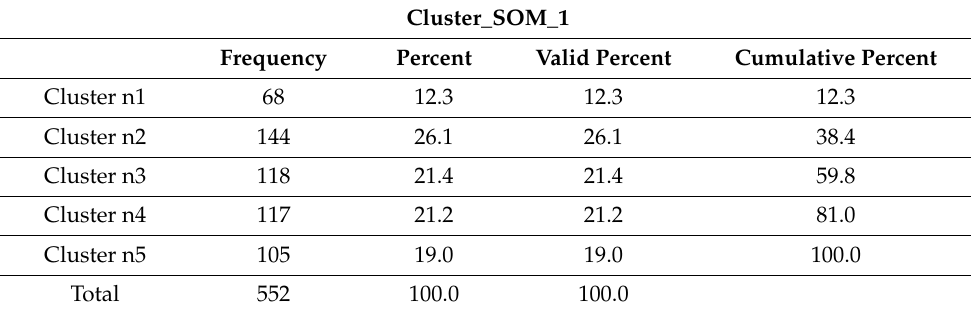
Table 8. Frequency of responses in each